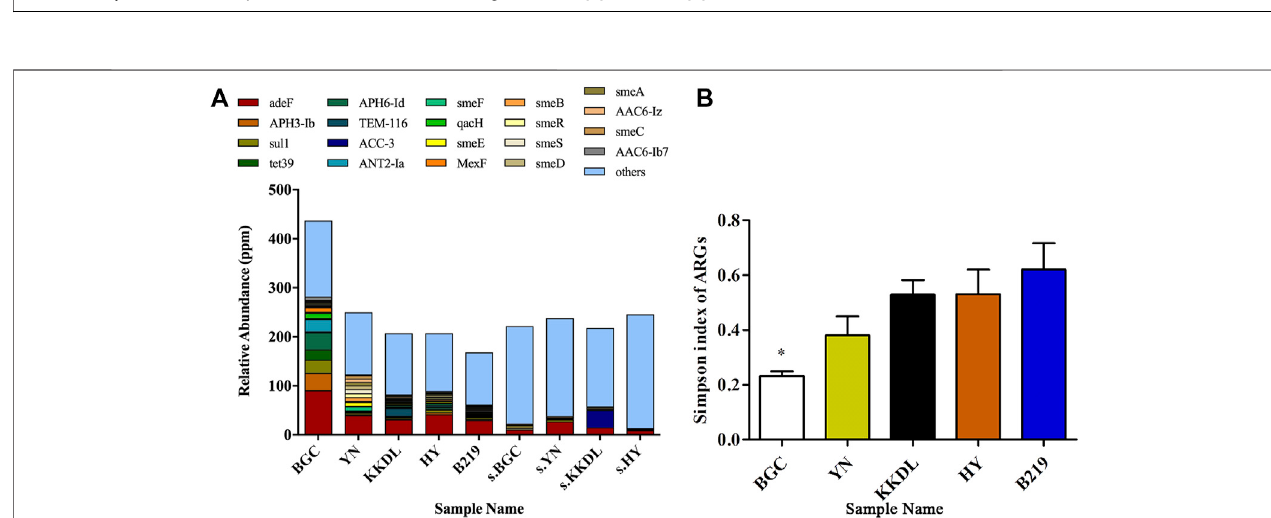
FIGURE 4 | Bacterial diversity between water and soil at the genus level. (A) PCA and (B)